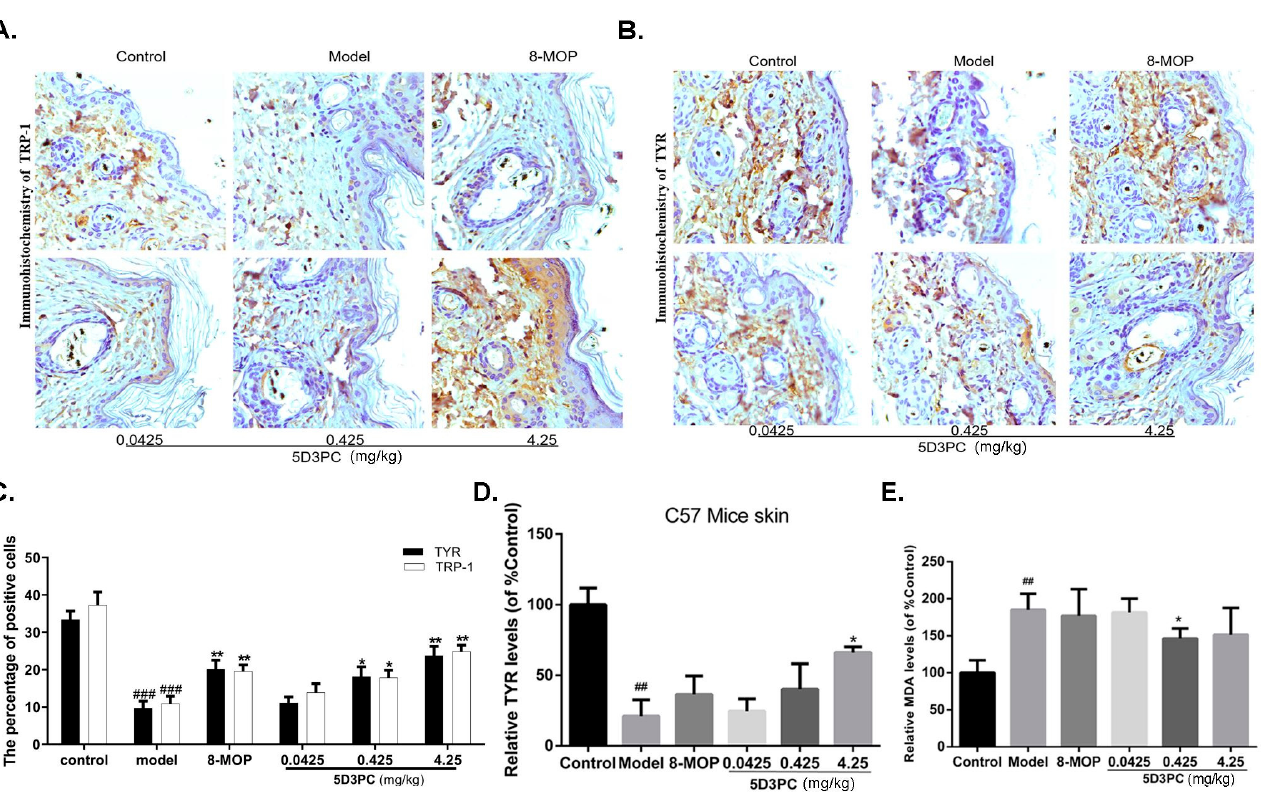
Figure 4. 5D3PC enhances the expression of TYR and TRP-1 in the skin of C57BL/6 mice. ( A ) and ( B ) Effect of 5D3PC on expression and content of melanogenic protein in C57BL/6 mouse skin. Immunohistochemical staining of TYR and TRP-1 in the skin of mice. showed positive staining for TYR and TRP-1. ( × 200, n = 10). ( C ) Depict quantitative data of positive cells. ( D ) C57BL/6 mouse skin-TYR levels were analyzed using a TYR assay ELISA kit. ( E ) Effects of 5D3PC on content of malondialdehyde (MDA) in serum of mice ( n = 10). C57BL/6 mouse serum-MDA levels were analyzed using an MDA assay ELISA kit. All results are expressed as mean ± SD; statistical analysis was performed with one-way ANOVA, followed by Tukey’s multiple comparisons test. ## p < 0.01, ### p < 0.001 compare with control group. * p < 0.05 and ** p < 0.01 compared with Model